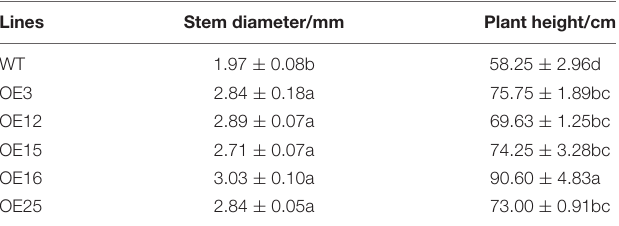
TABLE 1 | Stem diameter and plant height of WT plants and OE-MsASMT1 transgenic plants.